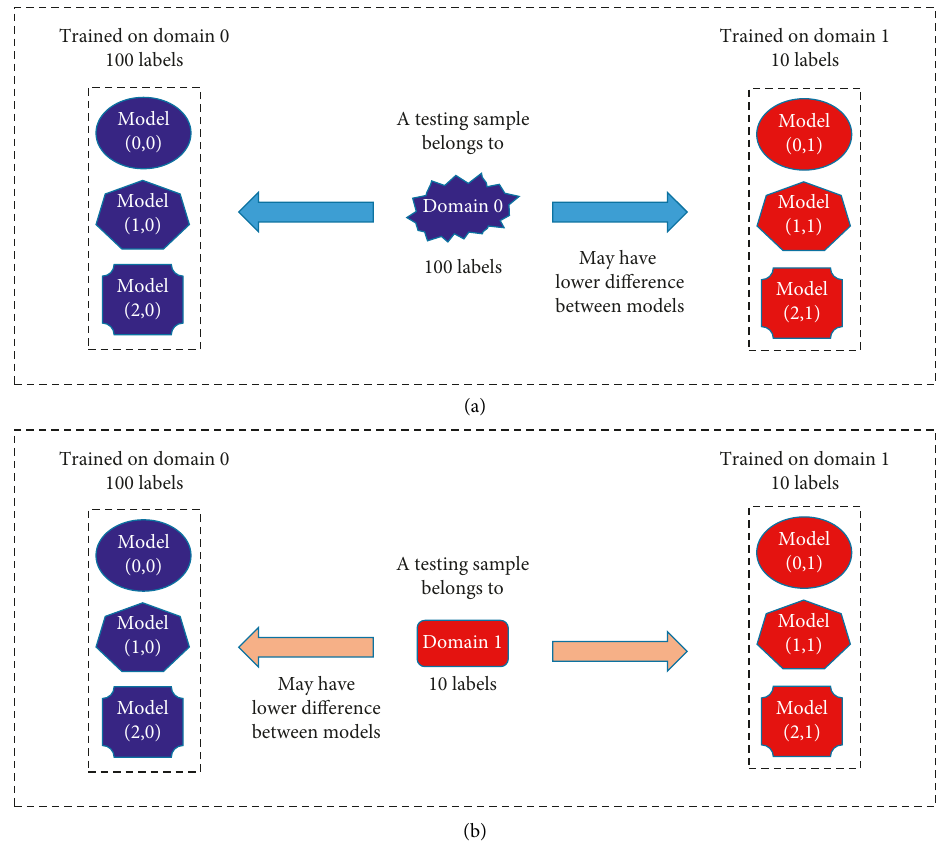
Figure 4: The two cases causing the wrong prediction of